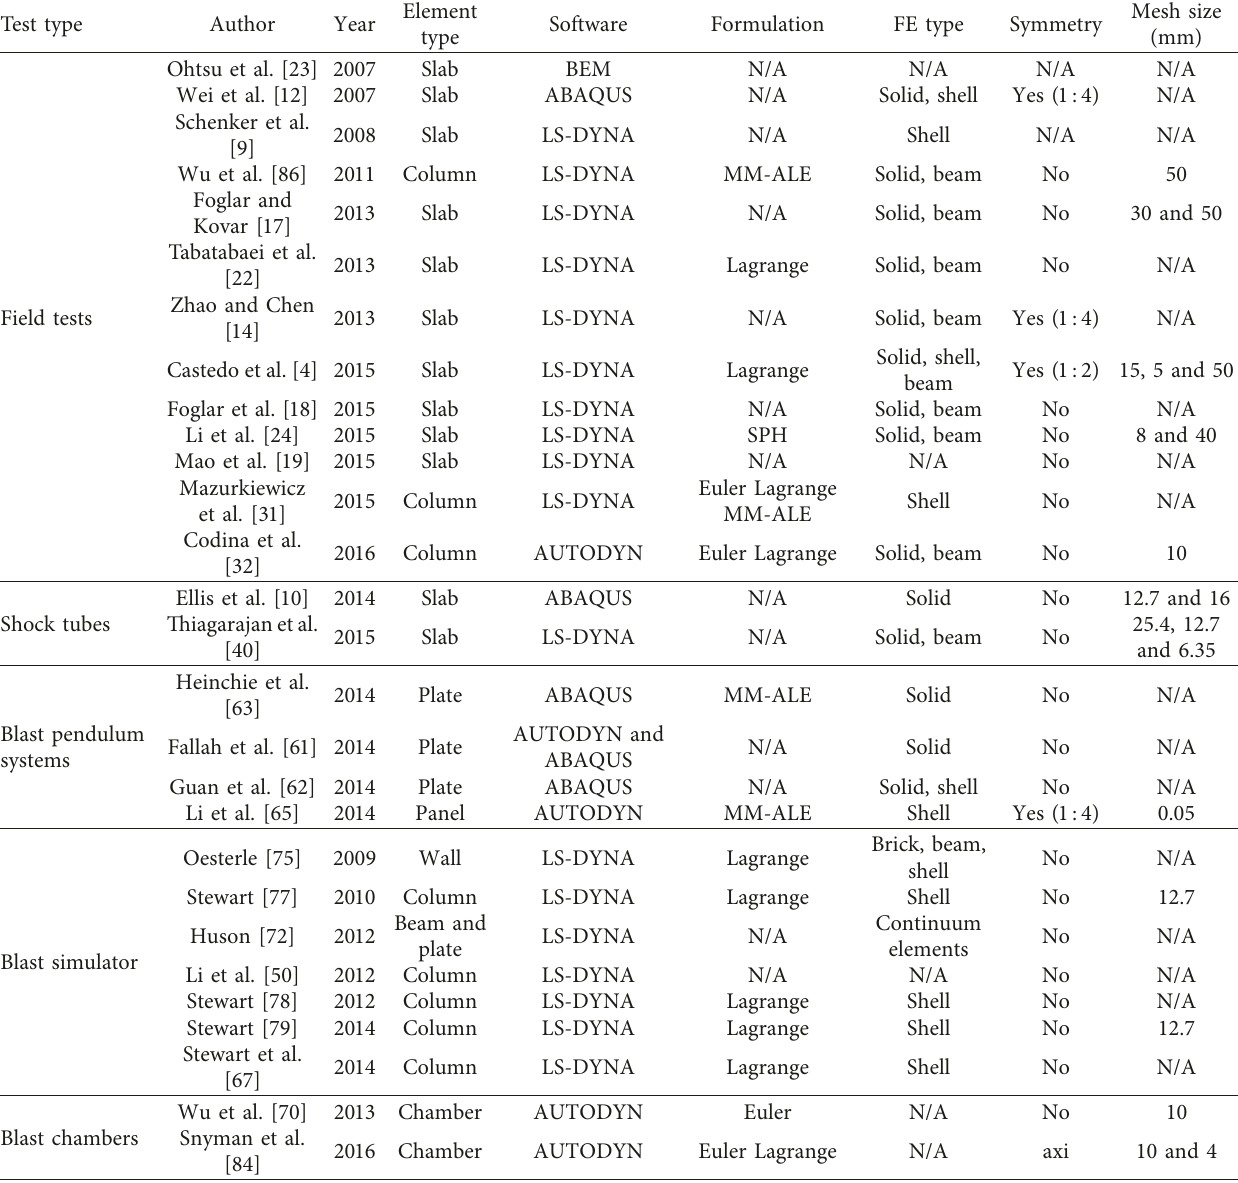
Table 6: Numerical simulations used for calculating blast effects.